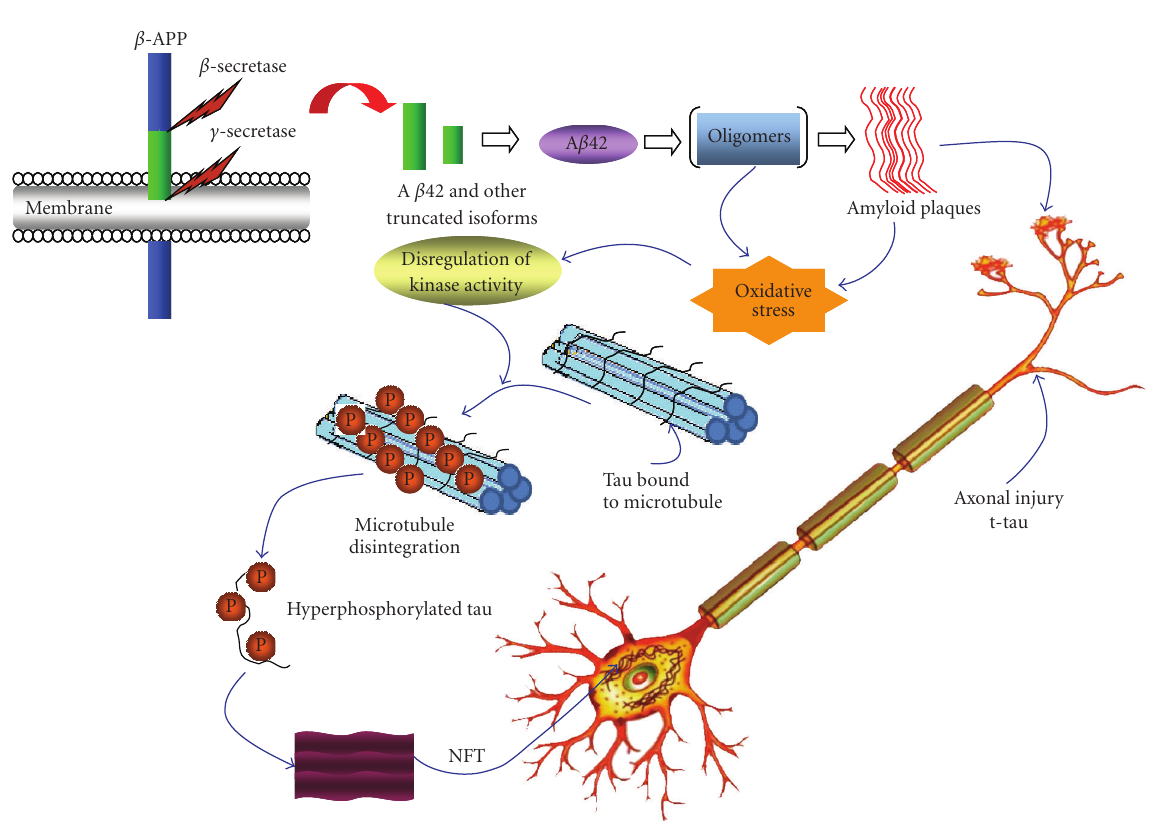
Figure 1: Pathological cascades and potential biomarkers of AD. Proteolytic cleavage of APP first by β -secretase followed by γ -secretase can produce A β 42 and other shorter A β fragments. The subsequent aggregation of A β 42 results in oligomers and amyloid fibrils. Amyloid fibrils are eventually deposited as senile plaques as shown. The toxicity of oligomers and amyloid fibrils could lead to the cascade of tau-hyperphosphorylation, which is otherwise bound to microtubules, providing microtubule stability. Upon hyperphosphorylation, tau dissociates from microtubules and aggregates into NFT, which could eventually cause increased cytoskeleton flexibility and neuronal